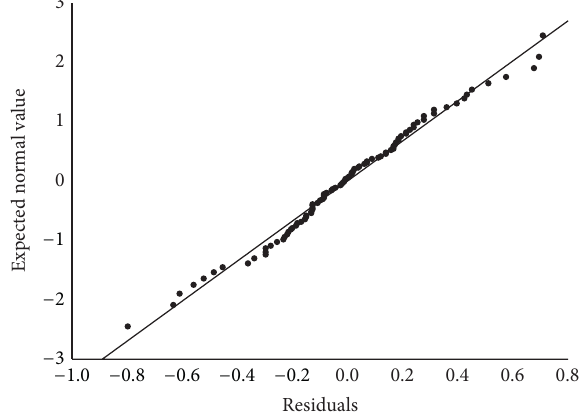
Figure 11: Presupposition of the normality of